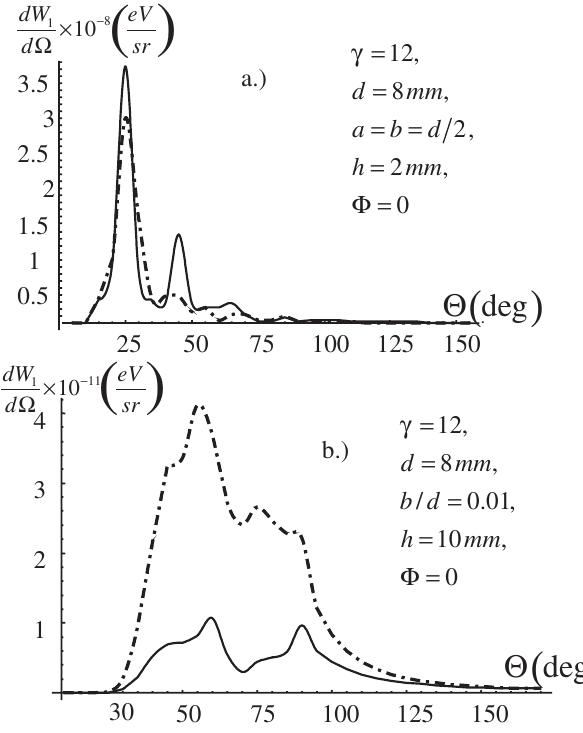
FIG. 9. Angular distribution of the SPR intensity (a) for a flat grating with thin strips: according to van den Berg’s model (a solid line—in region I ; a dash-dotted line—in region III ; a dotted line—for RDR model, should be multiplied by indicated factors); (b) the same for a perpendicular grating.